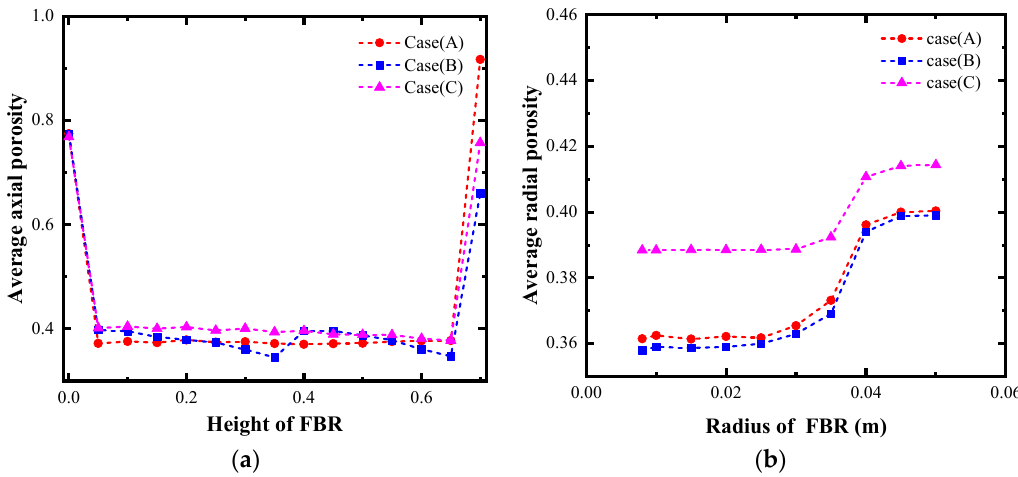
Figure 2. Average porosity distribution of three cases: ( a ) distribution of average axial porosity, and ( b ) distribution of average radial porosity.